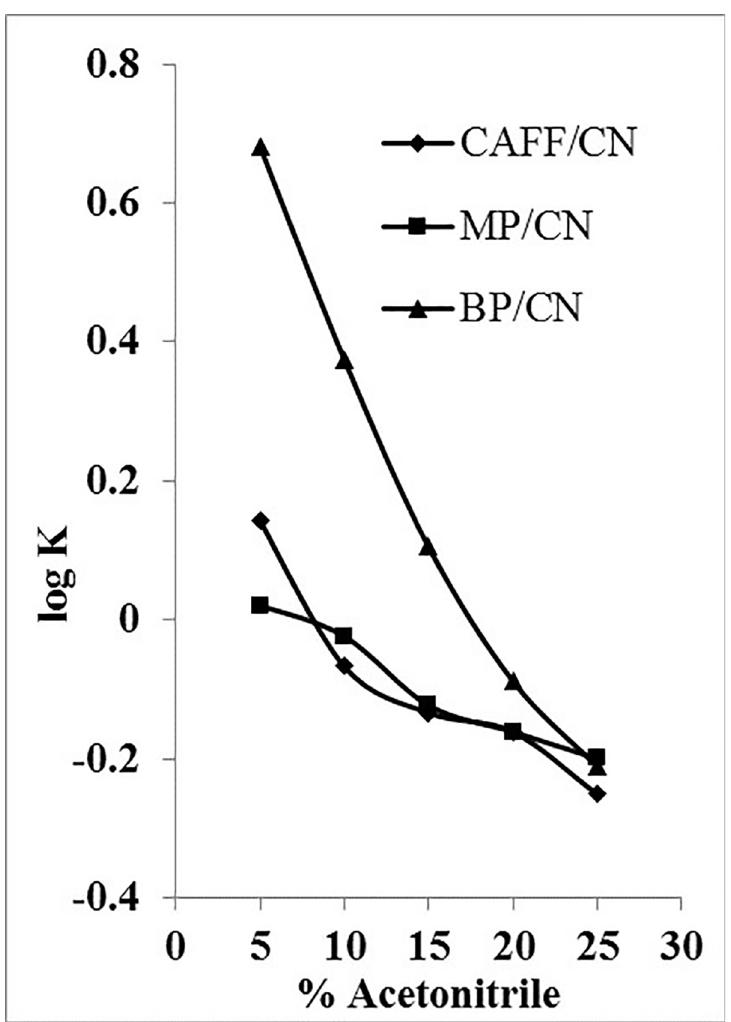
Fig 3. log k of CAFF, MP and BP as a function of acetonitrile concentration using CN column.